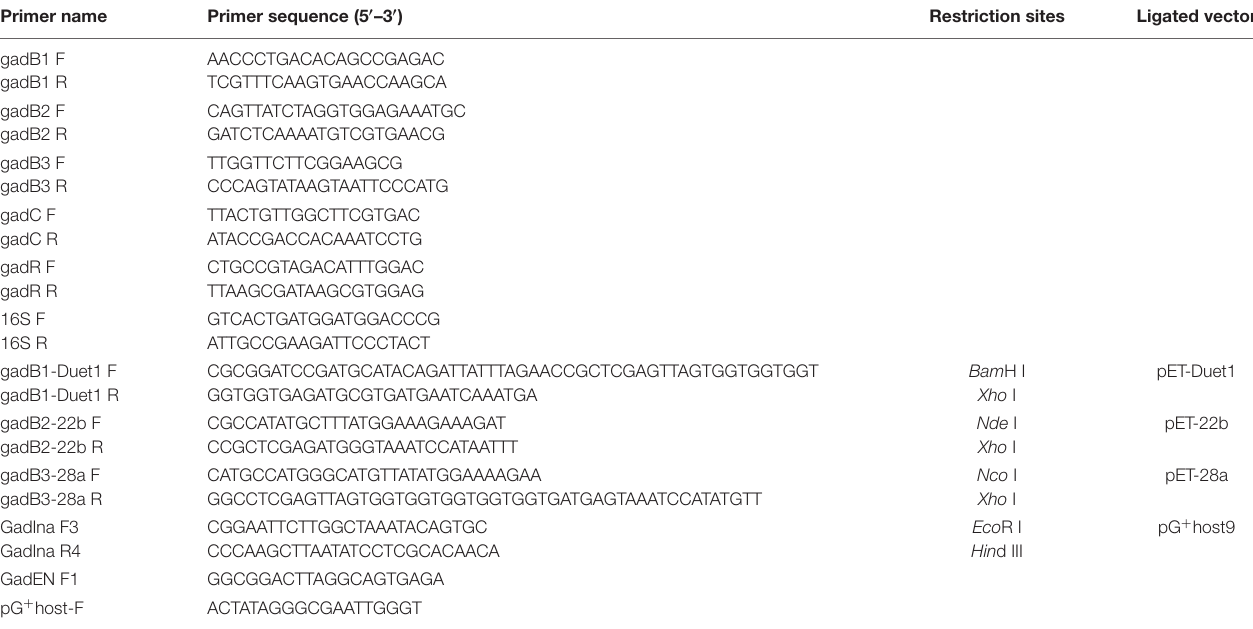
TABLE 2 | The primers used in this